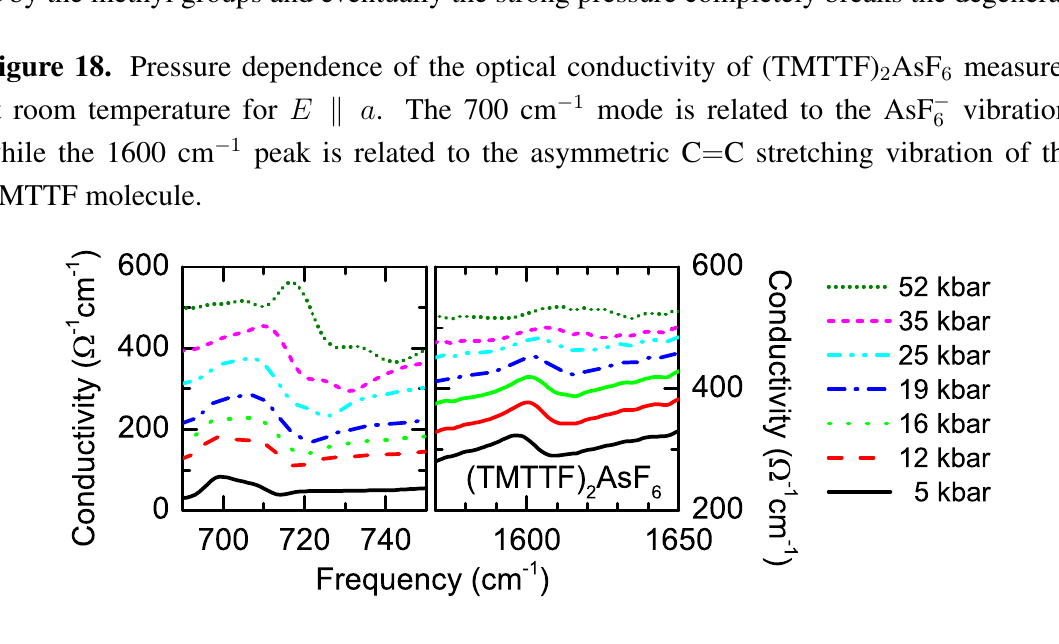
AsF measured 2 6 vibration, 6